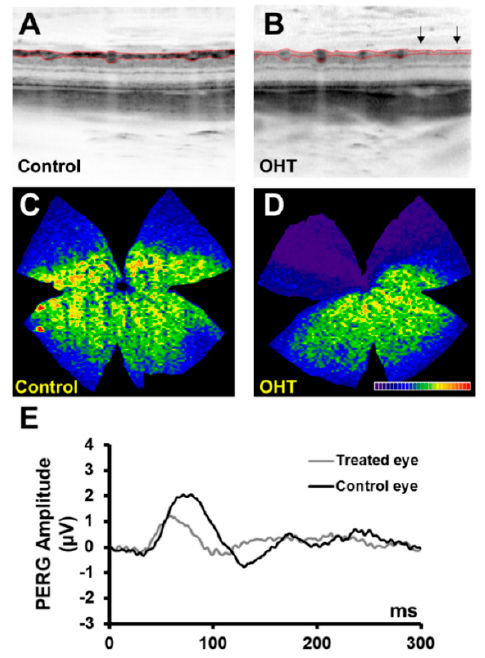
Figure 7. Two hypertensive eyes eventually progressed to develop distinct inner retinal changes. Here, we show a representative animal with a mean IOP in the hypertensive eye of 21.67 mmHg and of 11.70 mmHg in the fellow eye that was shown to develop structural retinal changes 24 weeks post-injection. ( A , B ) The RNFL + GCL + IPL showed significant thinning (60.33 µm) in the hypertensive eyes vs. the control eyes (73.44 µm), as measured with the OCT. ( C , D ) Isodensity maps depicting the Brn3a + RGC distribution in a hypertensive and control retina. In contrast to the normal distribution of Brn3a + RGCs observed in the control right retina ( C ), the hypertensive retina ( D ) shows a typical sector located approximately between the 9:30 and 1:30 clockface positions that are almost free of Brn3a + RGCs. ( E ) PERG P50 amplitude values were also significantly reduced in the hypertensive eye (1.19 µV) compared to the control eye (2.09 µV).